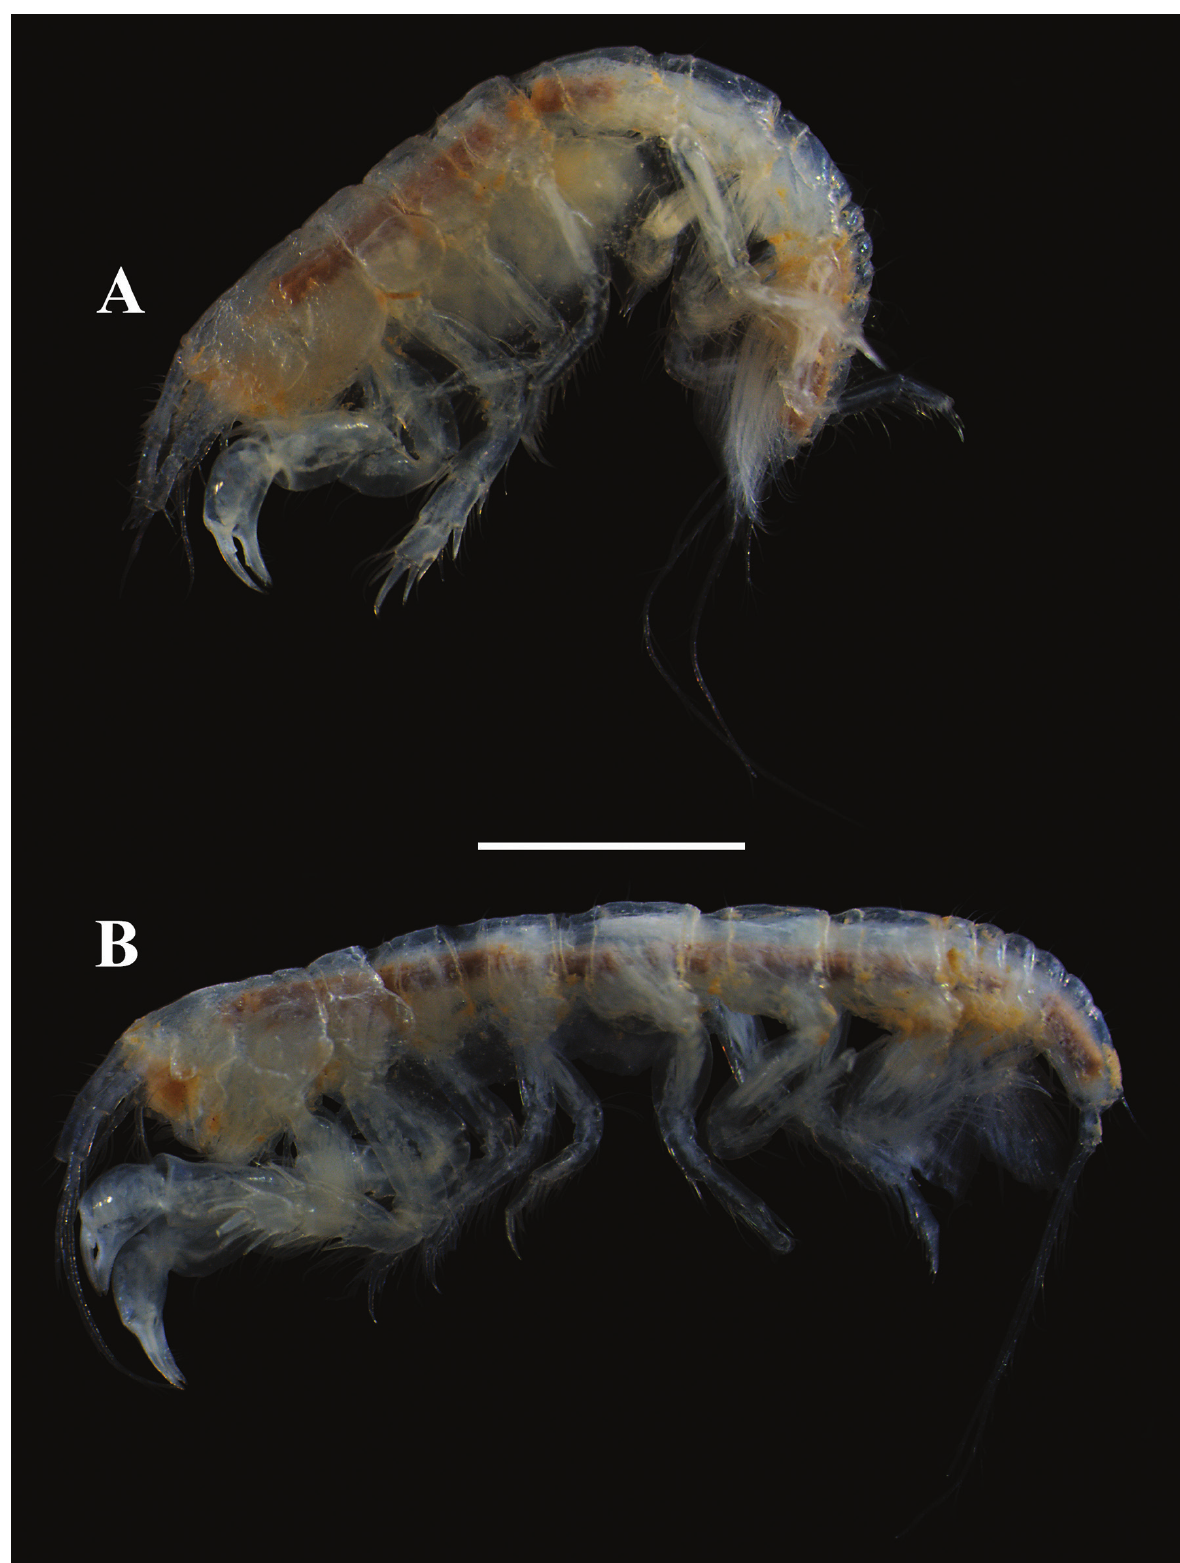
Figure 13. Digital images of Brachylicoa lui sp. n. A holotype (female with oostegites and genital cone), lateral view of habitus, length 8.13 mm; B paratype (female with marsupium and genital cone) lateral view of habitus, length. Scale bar = 2.0